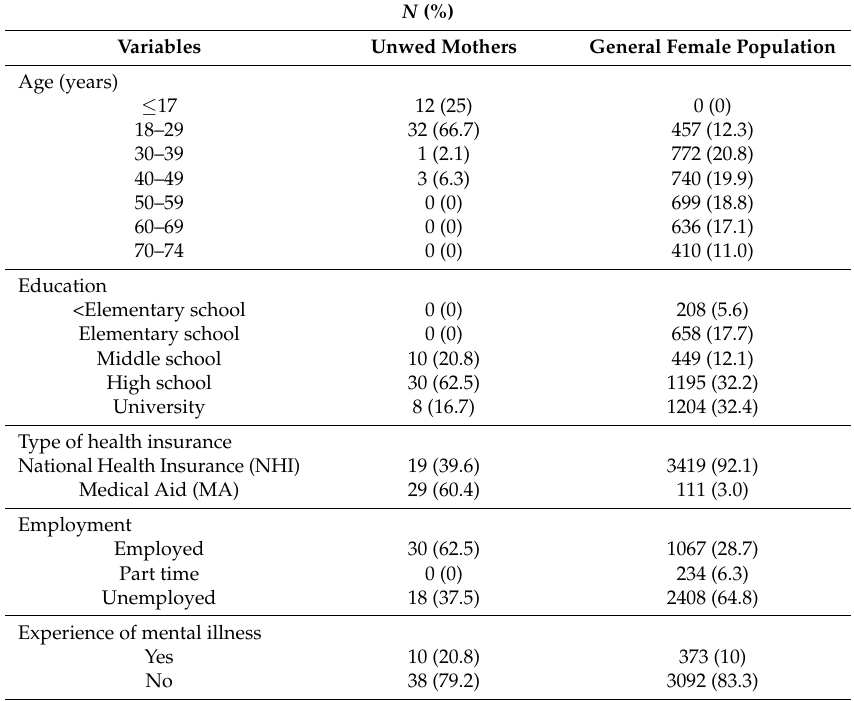
Table 1. Sociodemographic variables of unwed mothers ( N = 48) and the general female population ( N =